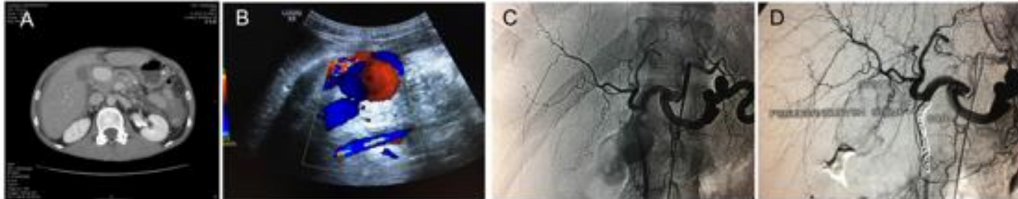
Figure 5. Diagnosis and treatment of a pseudo-aneurysm of the gastroduodenal artery in a patient with severe acute pancreatitis. ( A ) Abdominal angio-CT revealing a large contrast-enhanced mass, ( B ) characteristic swirl flow in abdominal ultrasound-Yin-Yang sign, ( C ) digital subtraction angiography (DSA) showing the large pseudoaneurysm projected over the gastroduodenal artery, and ( D ) DSA showing the post trans-arterial embolization of the gastroduodenal artery with multiple coils.